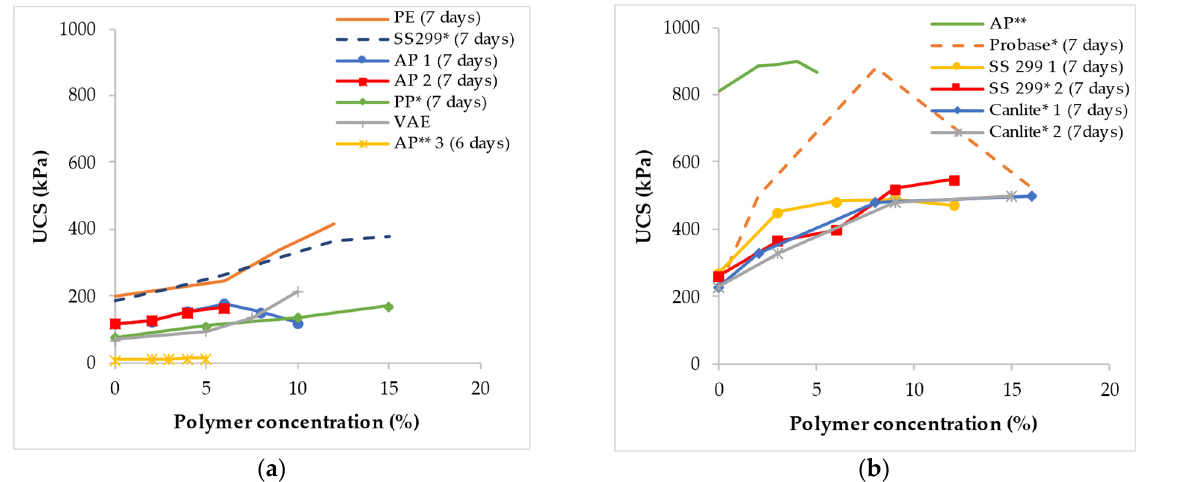
Figure 5. Influence of polymer treatment on the UCS of: ( a ) Clayey soil; ( b ) Silty soil (* indicates polymer concentration as a % of dry weight of soil and ** as a % of weight of water). Note: these figures were created with data obtained from [110,139,142,143,147,152–154,156–159].